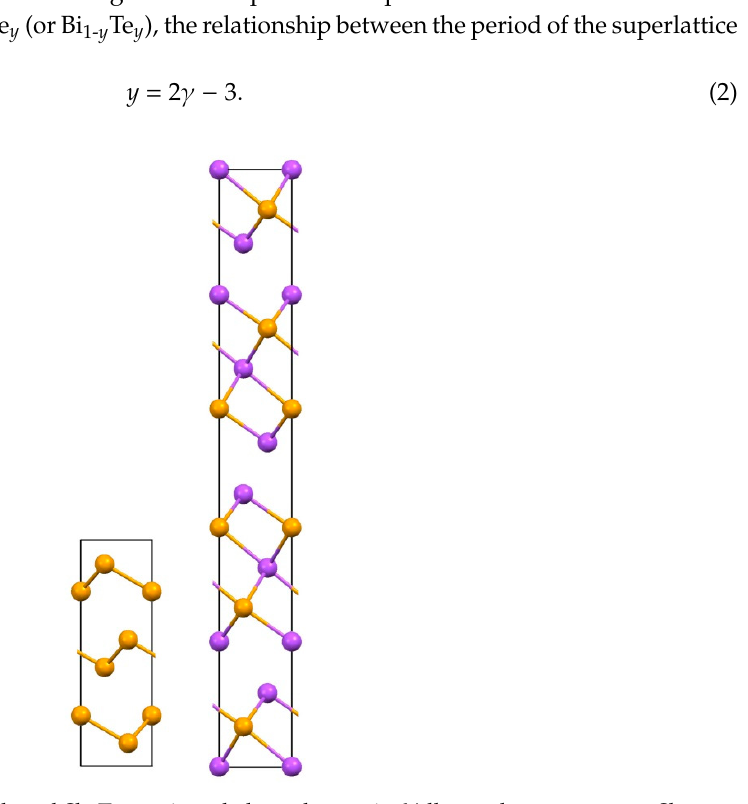
Figure 1. Crystal structures of Sb and Sb 2 Te 3 projected along the a -axis. Yellow spheres represent Sb, and purple spheres represent Te.